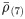
Estimated recovered and active cases, ρ¯(7) and EPG.
ρ¯(7) is computed using the mean value for the last three days.EPG: Effective Potential Growth described in the text. To interpret table data we must take into account Detection Delay, because they are computed using the reported data. Data updated on April 20, 2020. *Belgian data are biased due to reporting of unconfirmed death cases. On that date the shift was 48% [34].